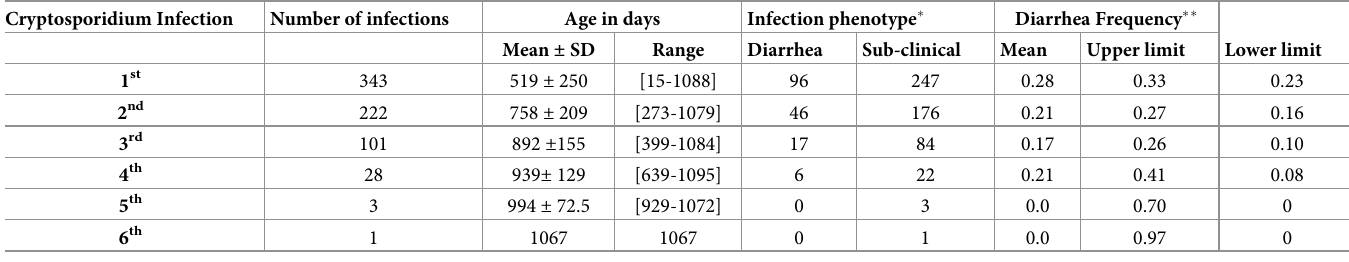
Table 1. Frequency of Diarrheal Cryptosporidiosis in Repeated Infections. Cryptosporidium